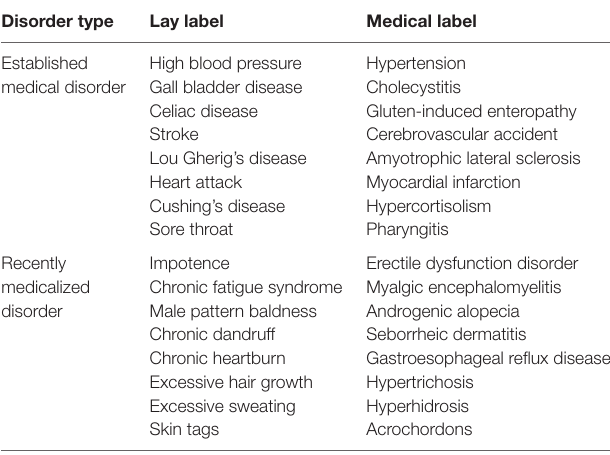
Table 2 | Mean urgency ratings as a function of the type of disorder and type of language used.